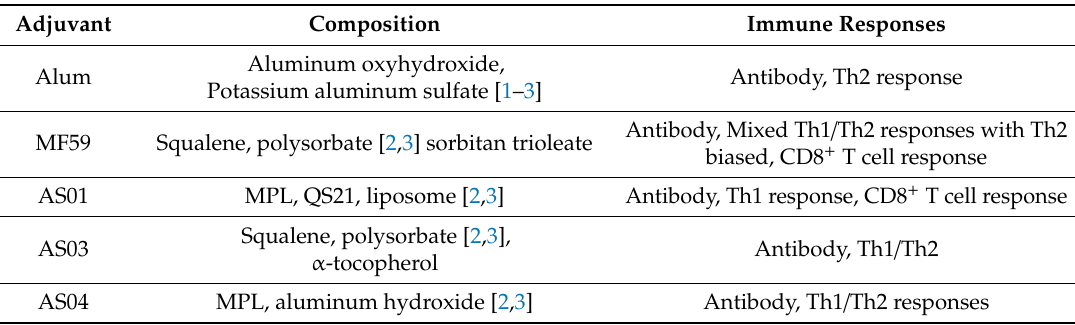
Table 1. Licensed vaccine